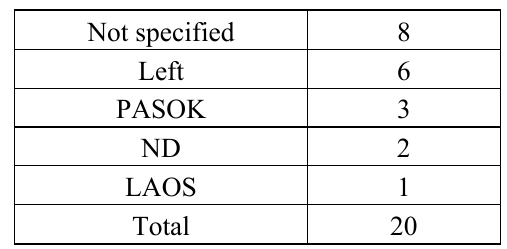
Table 7. Political affiliation of the 20 central blogs.